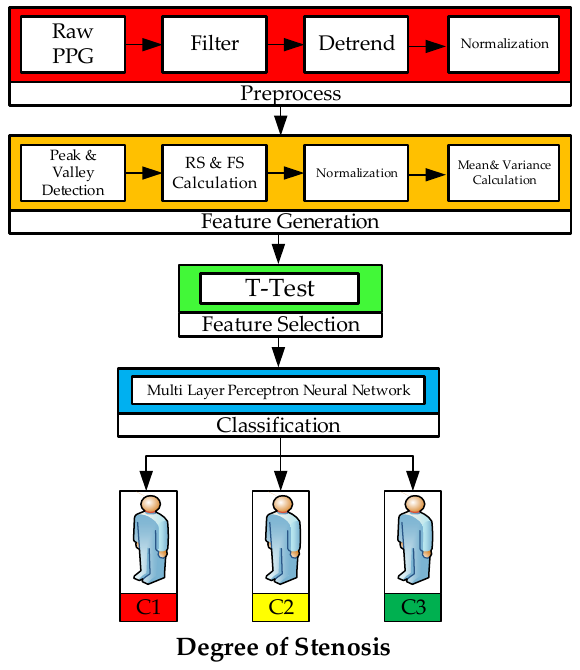
Figure 2. The technique used in the system development.